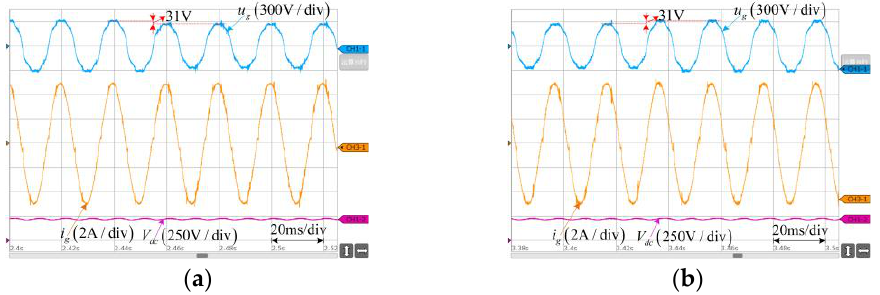
Figure 20. Experimental waveforms of proposed controller under grid voltage amplitude jump. ( a ) Step up, ( b ) step down.